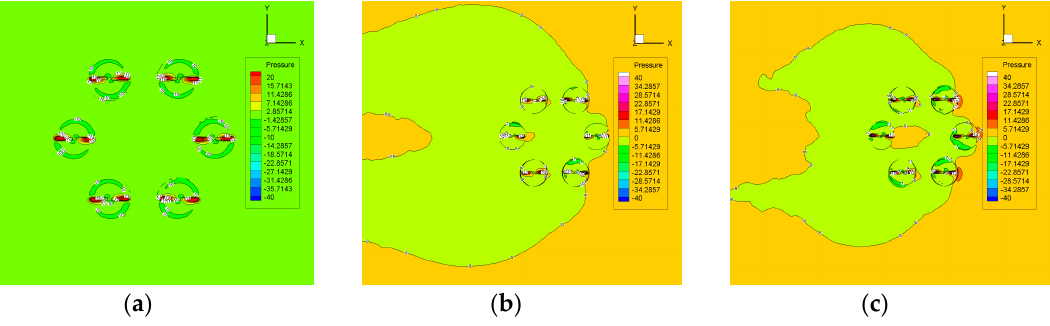
Figure 11. Pressure distribution on the plane upper 10 mm of the center of the Hex-rotor UAV ( a ) 0 m/s ( b ) 2.5 m/s ( c ) 4 m/s.